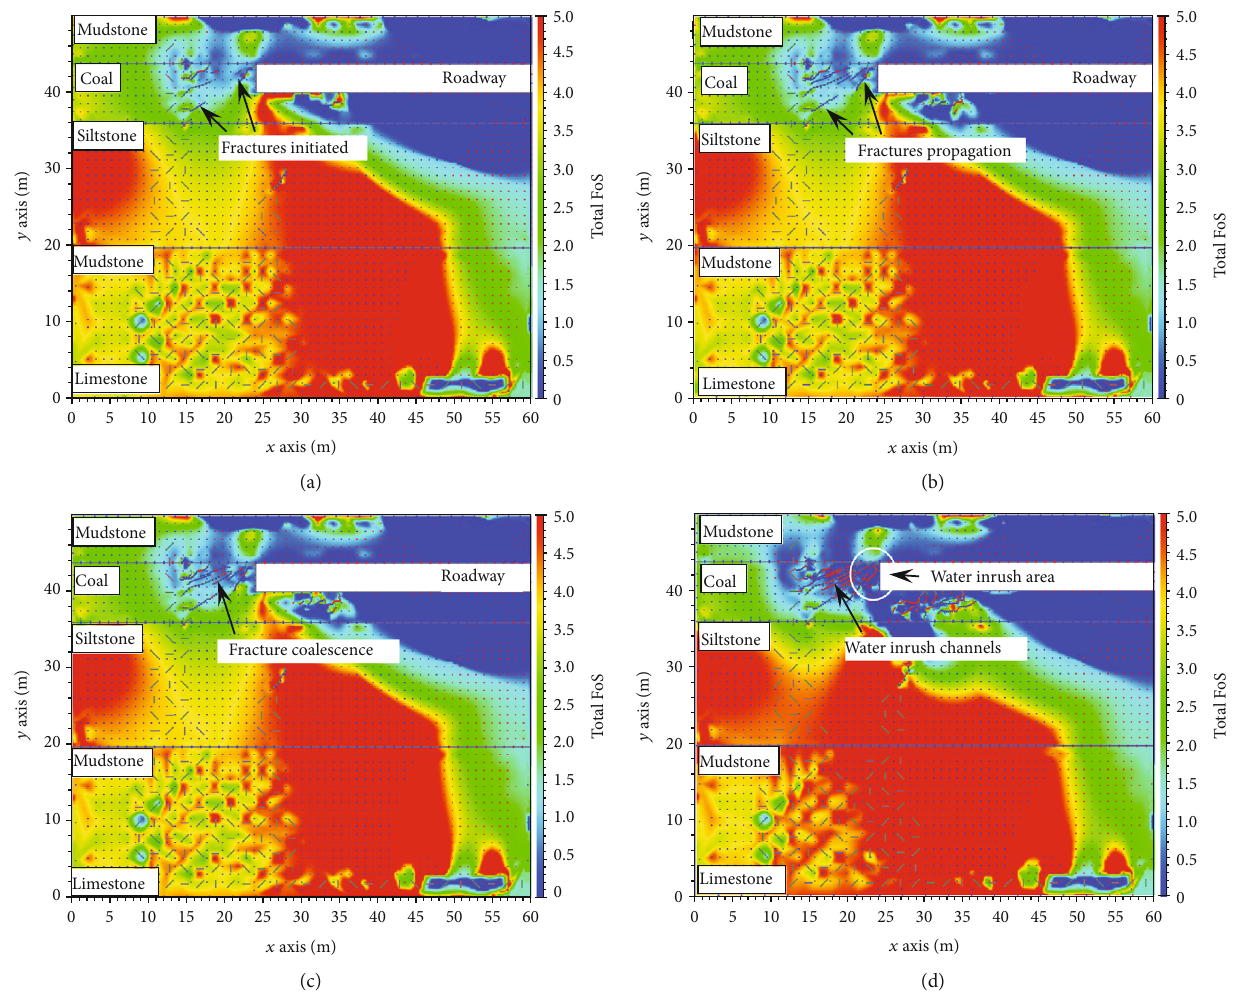
Figure 10: Distribution of modelled total FoS in the surrounding rock mass: (a) cycle 9, (b) cycle 12, (c) cycle 14, and (d) cycle 24.